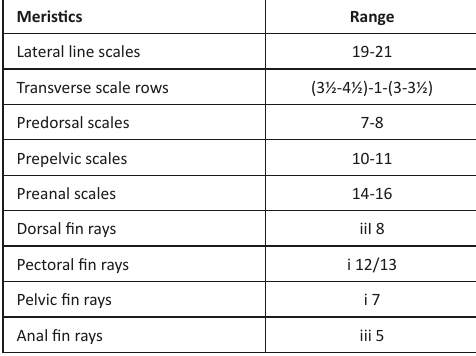
Table 2. Range for meristics of Pethia setnai (n =